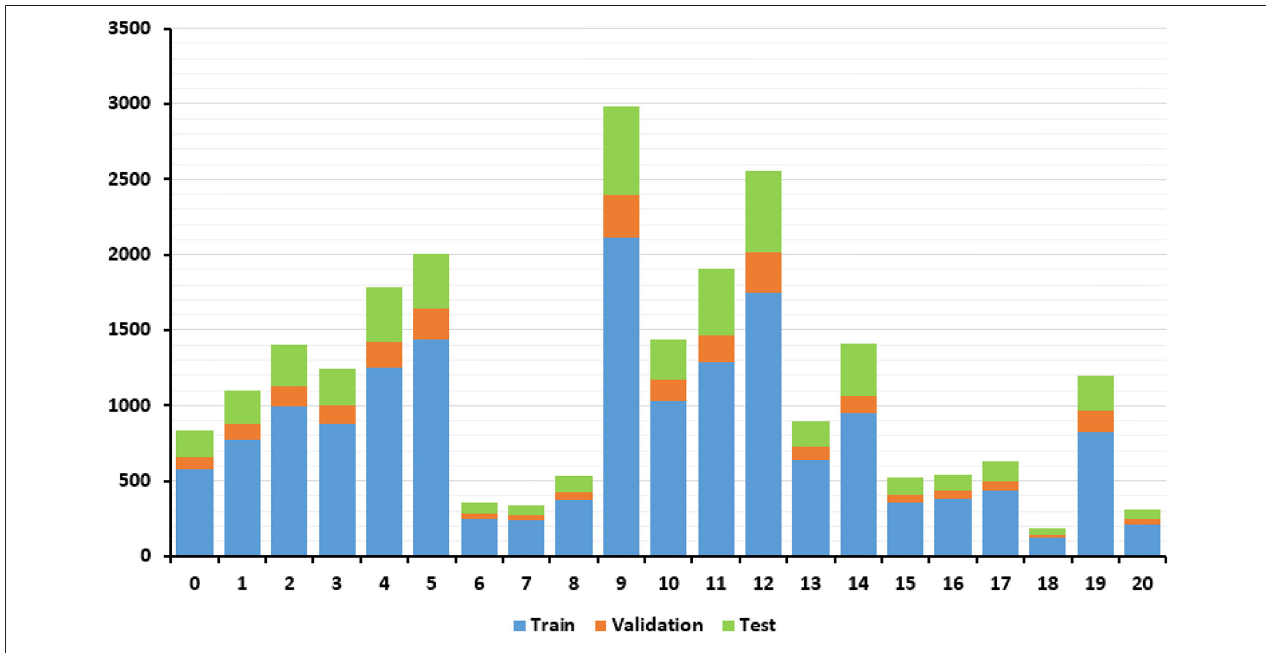
FIGURE 2 | Dataset split and distribution of